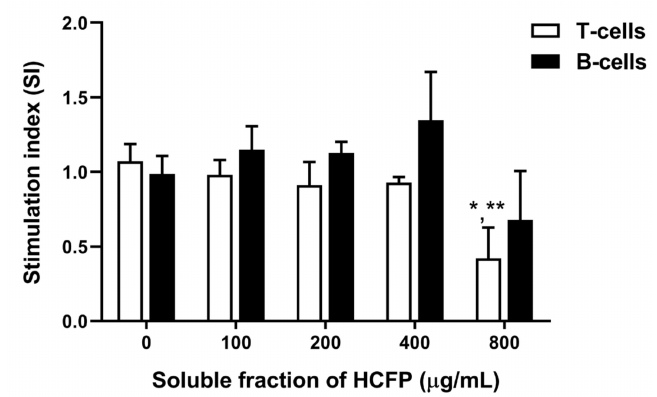
Figure 3. Effect of soluble fraction of HCFP on rat splenocyte mitogen-driven proliferation at 48 h. Stimulation index (SI) was expressed as mean ± SEM from three independent experiments performed in triplicate. * p < 0.05 and ** p < 0.01 indicate significant differences between different concentrations and control (0 µ g/mL). Statistical significance was determined using one-way ANOVA followed by Dunnett’s multiple comparison